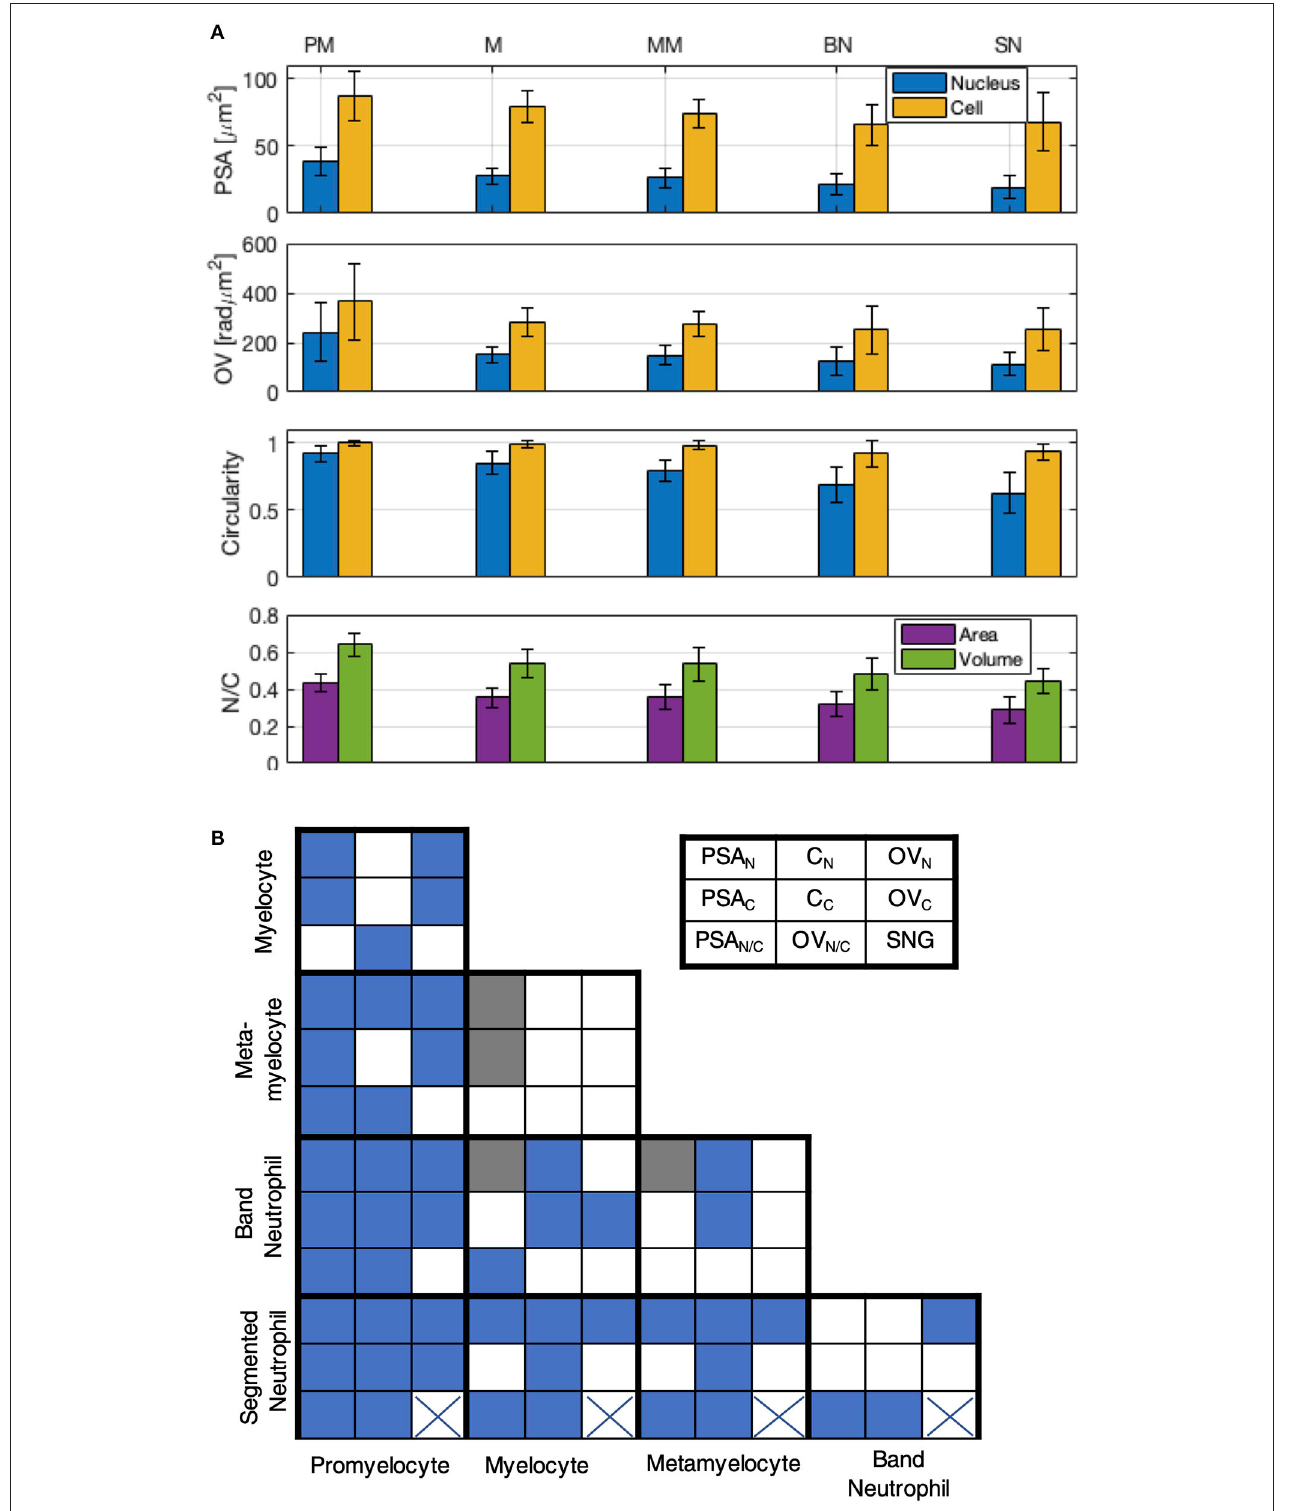
FIGURE 3 | Cell and nucleus morphological parameters. (A) Projected Surface Area (PSA), Optical Volume (OV), Circularity (C), and ratios of nucleus to cell, NC, of PSA and OV. Mean and SD values for: promyelocytes (PM, N = 22), myelocytes (M, N = 21), metamyelocytes (MM, N = 24), band neutrophils (BN, N = 21), segmented neutrophils (SN, N = 25). (B) Diagram showing the results of the Mann-Whitney U test calculated for nine parameters, for each class pair. A p -value < 0.05